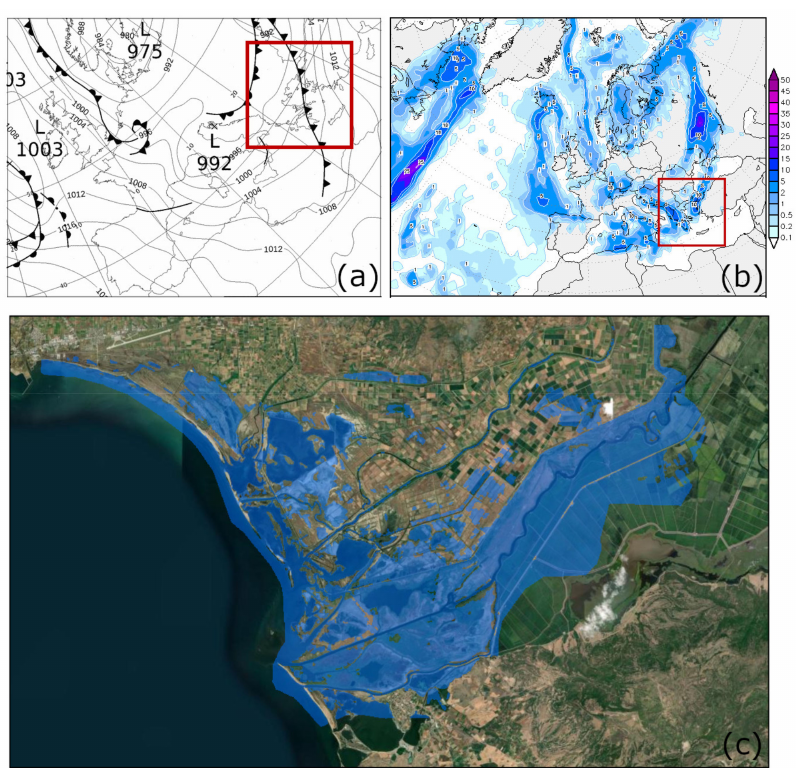
Figure A5. As in Figure A1, but for the first 2015 flood